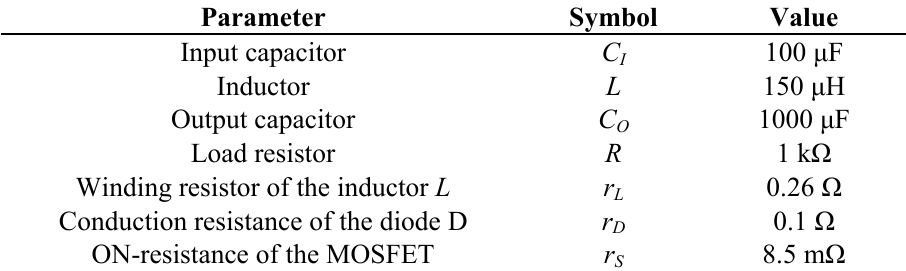
Table 1. Circuit parameters of the thermoelectric power generation